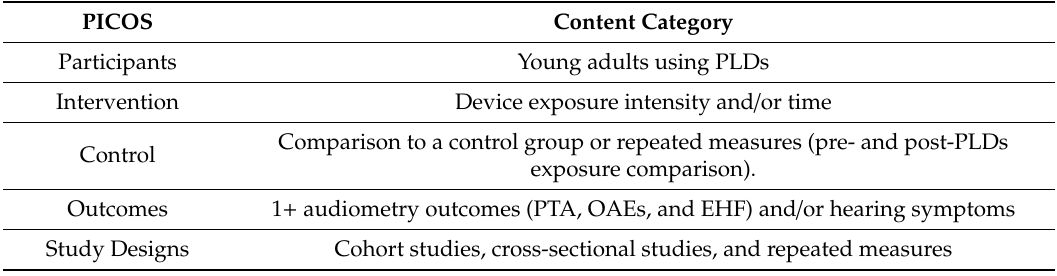
Table 1. Inclusion criteria based on PICOS